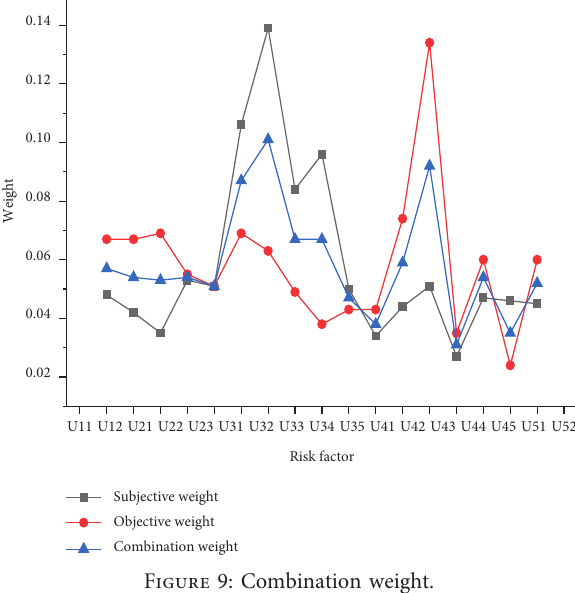
Figure 9: Combination weight.